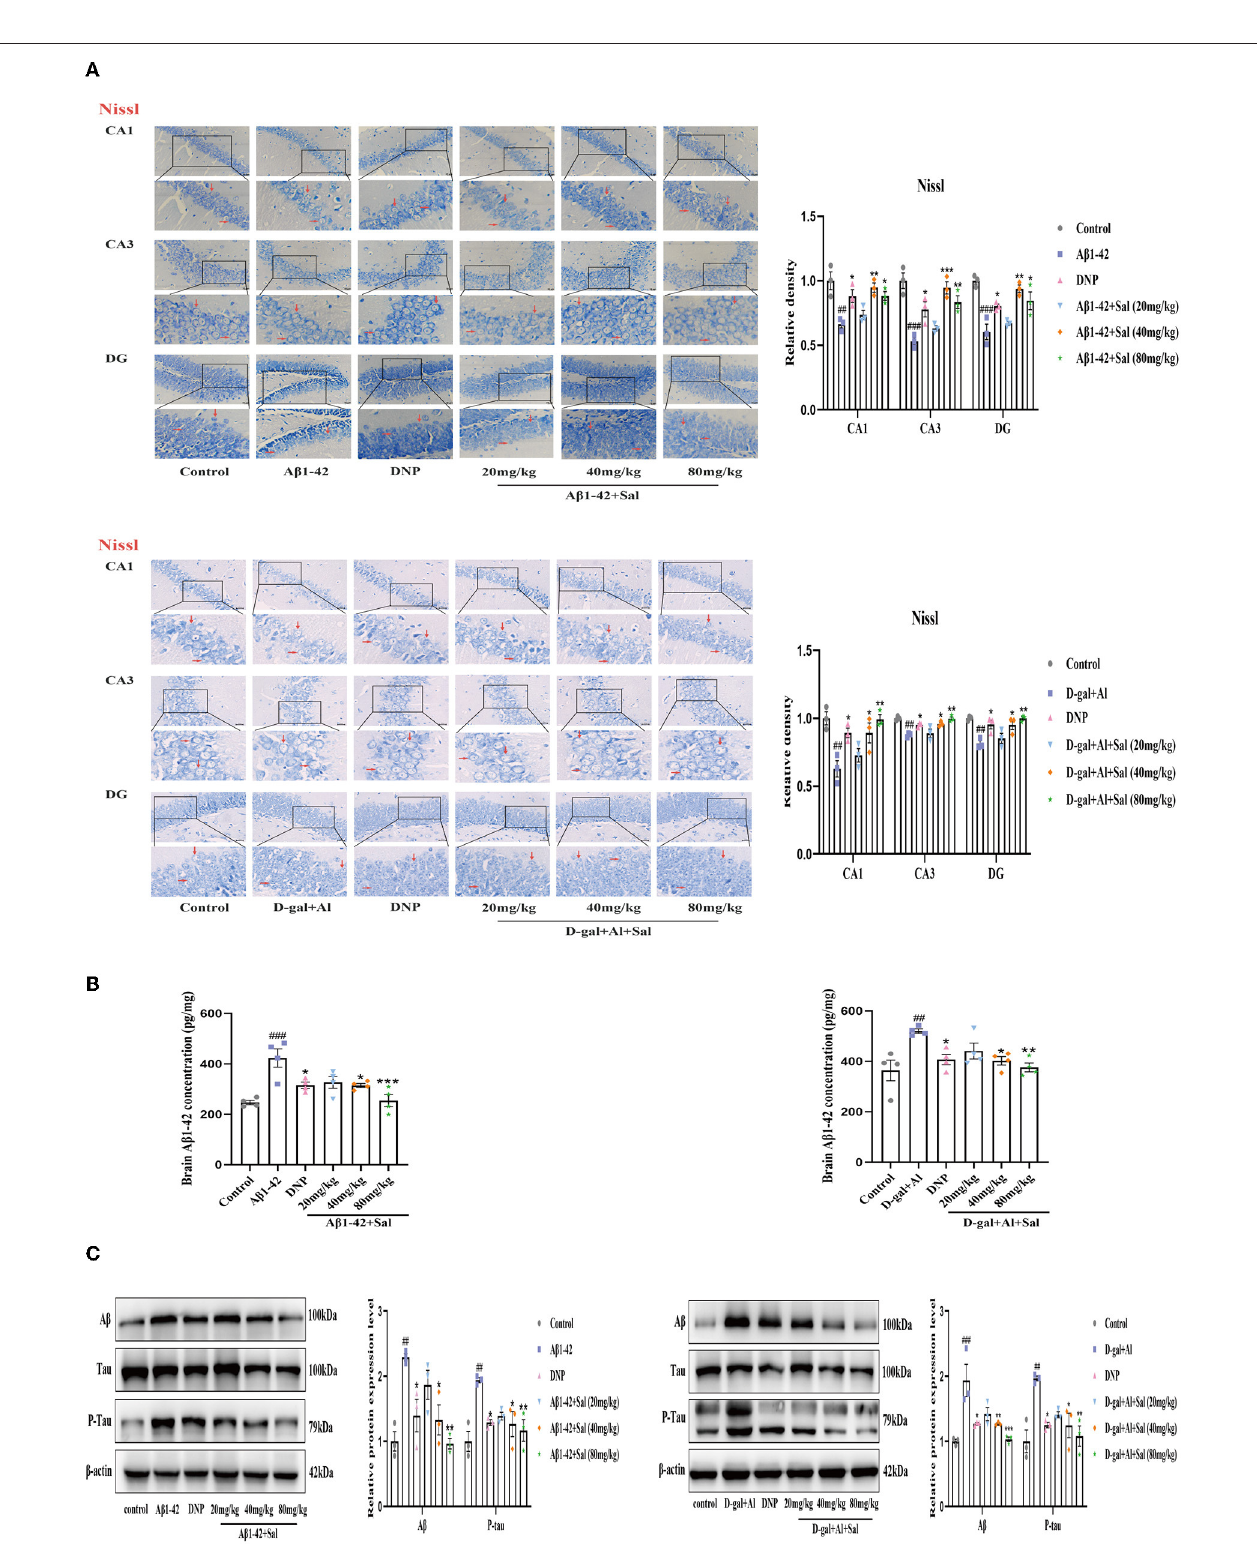
FIGURE 4 | Sal alleviated neuronal injury and downregulated A β , P-Tau in A β 1-42 and D-gal/AlCl 3 -induced AD mice. (A) Representative photomicrograph of Nissl staining in the CA1, CA3, and DG regions of the hippocampus of the A β 1-42 and D-gal/AlCl 3 -treated group. Neuronal damage increased after administration